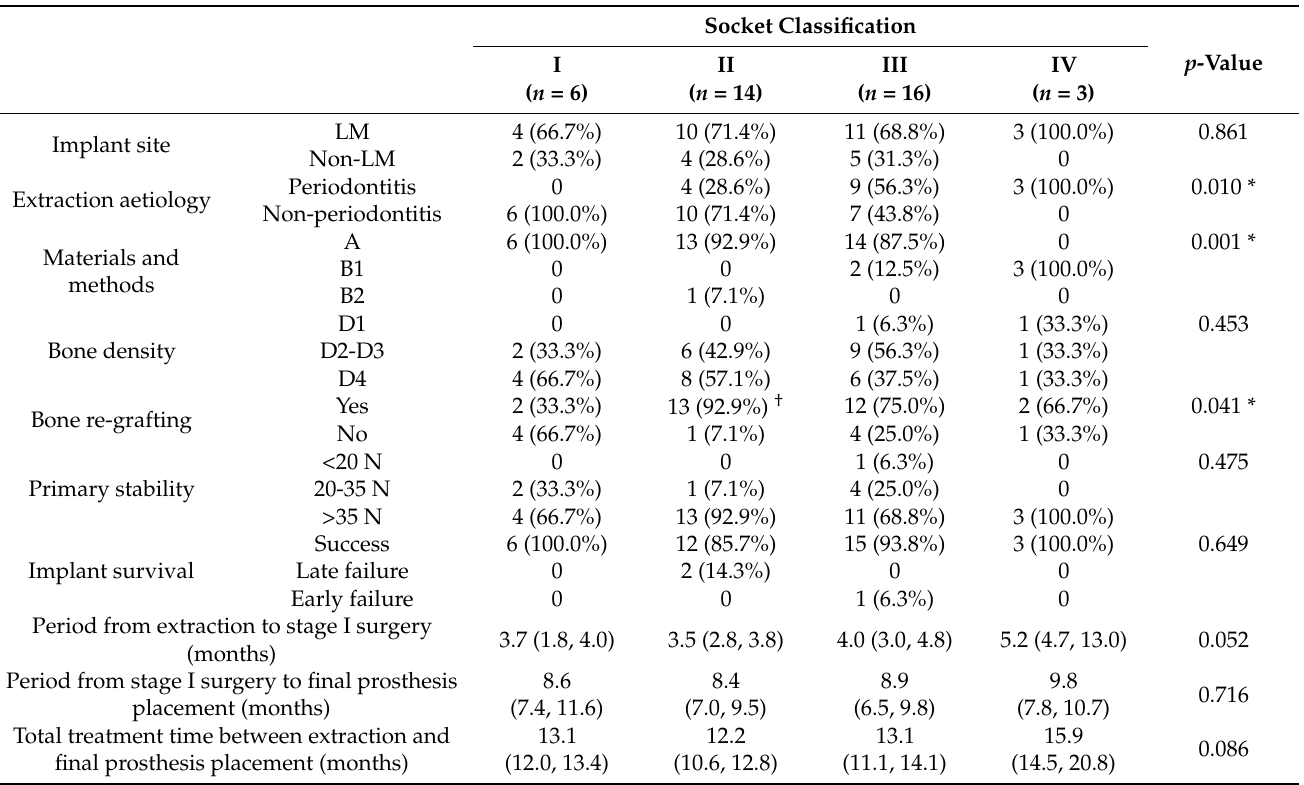
Table 4. Association of socket classification and implant site development for mandibular implants with flapless ridge